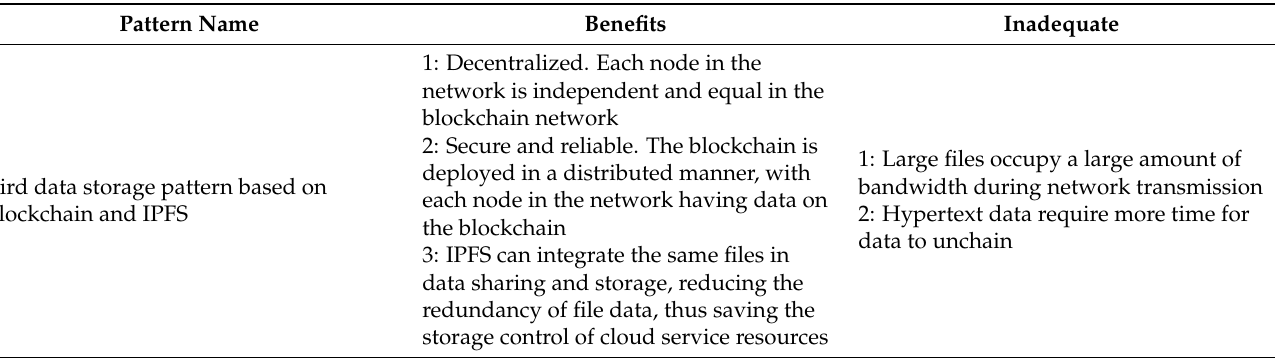
Figure 3. Schematic diagram of Stachyris nigriceps data uploading to the blockchain. Table 1. Bird data storage pattern based on blockchain and IPFS characteristics